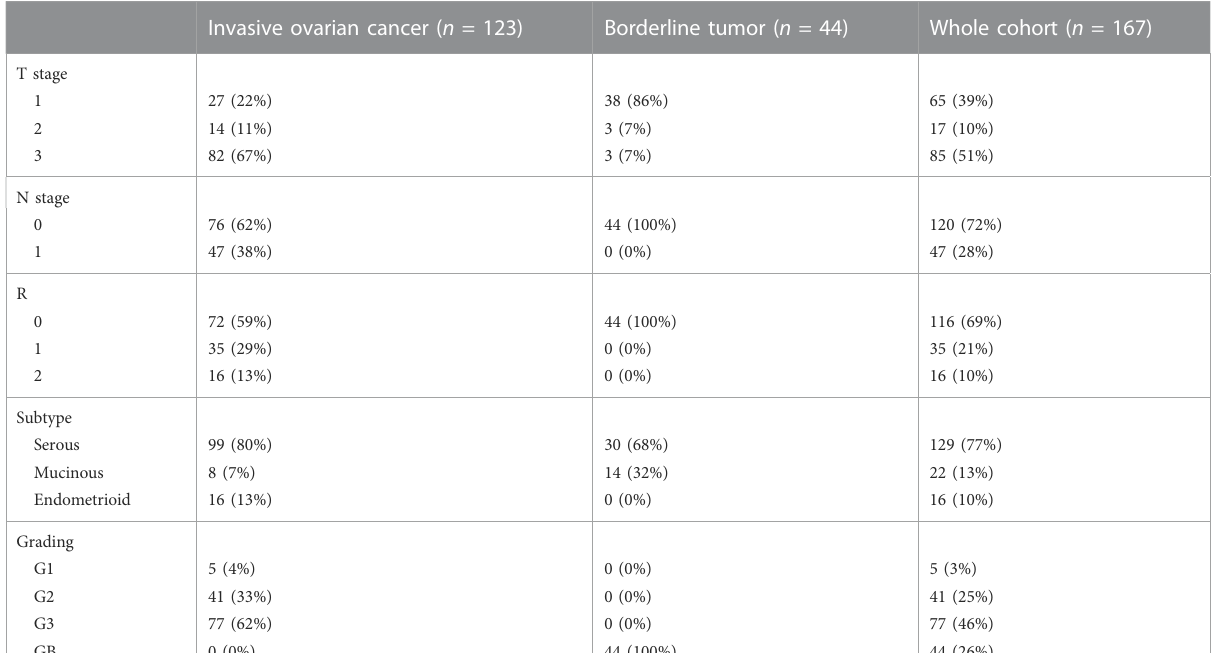
TABLE 2 Tumor characteristics ( n = 167).